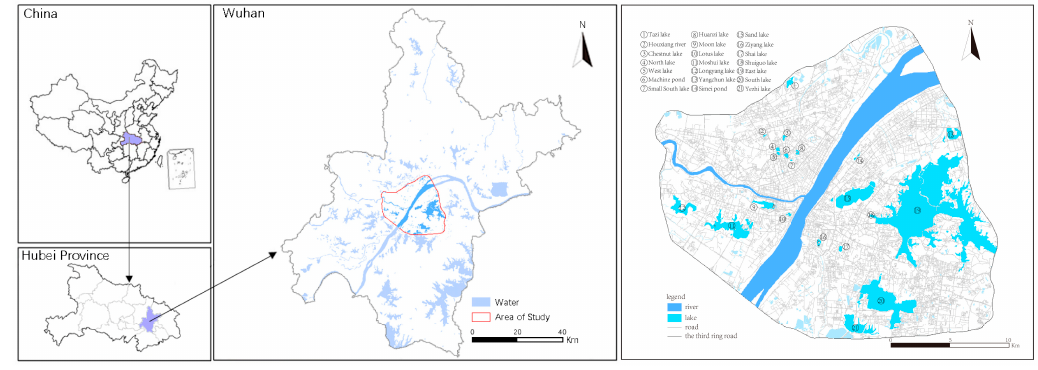
Figure 1. Location of the study area.